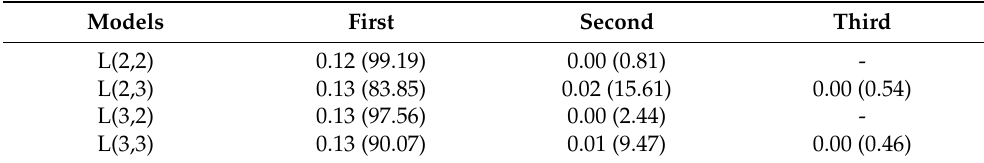
Table 4. Eigenvalues of the permanent environmental (co)variance matrix and the proportion of total variance (%) estimated from the Legendre